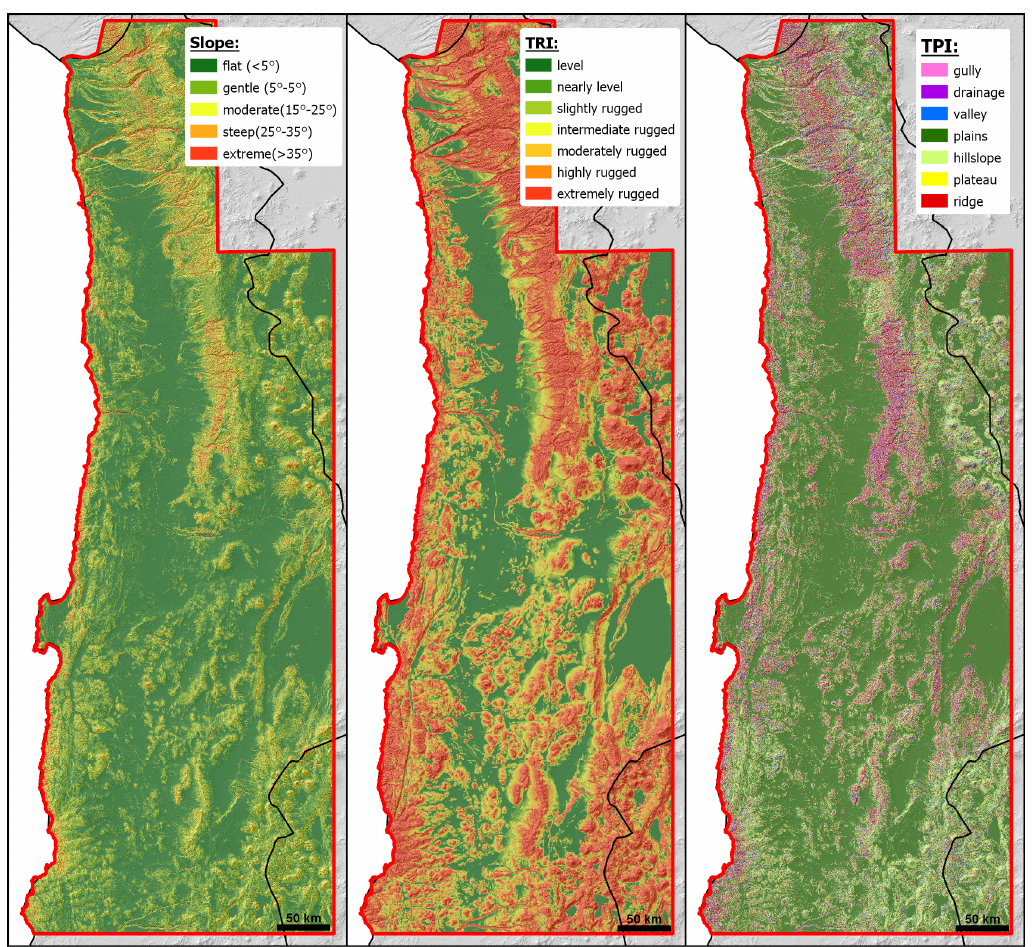
Figure 4. Spatial distribution of extracted terrain features slope, terrain ruggedness index (TRI) and topographic position index (TPI). Map is based on SRTM elevation data.